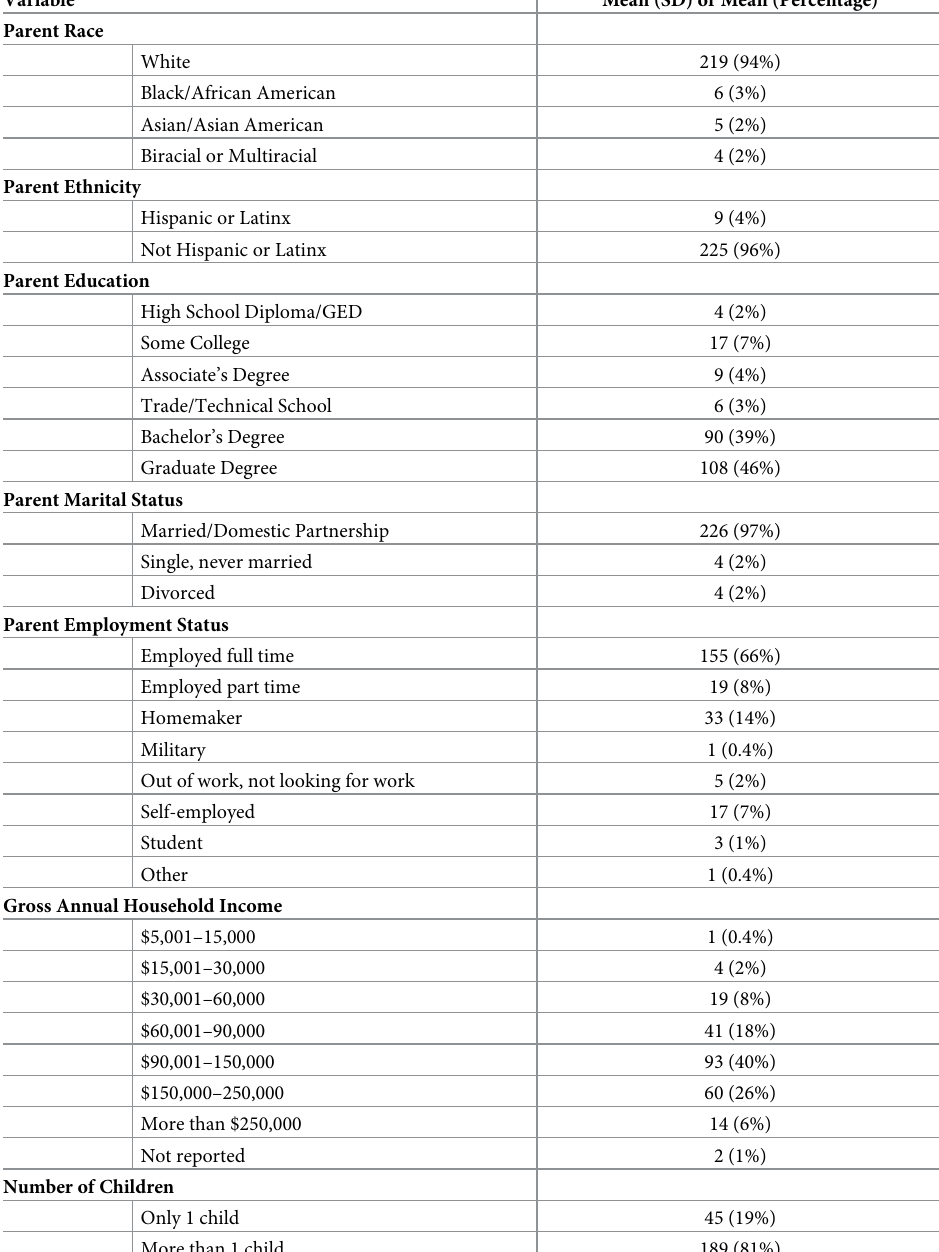
Table 1. Participant